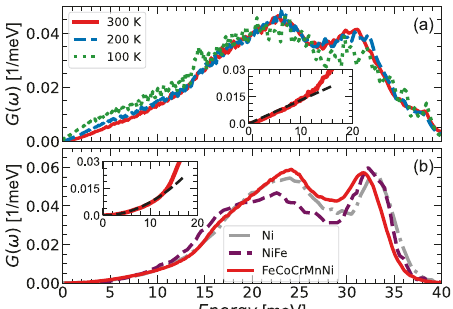
Fig. 1 | Neutron diffraction. The neutron diffraction pattern of the polycrystalline sampleofFeCoCrMnNi,usedforneutronexperiments,isreported,measuredat3T- 2@LLB with an incident neutron wavelength of 1.230 Å at 300 K. Peaks have been fi tted with LeBail-type pattern matching with a FCC structure, space group Fm (cid:1) 3 m . The fi t is reported as a solid red line, observed data points in black and difference plot in blue. The inset is a visual interpretation of the FeCoCrMnNi FCC structure (madewithVESTA 76 )inwhicheachofthe5elementshasequalchanceofoccupying each atomic position, creating a random solid solution.